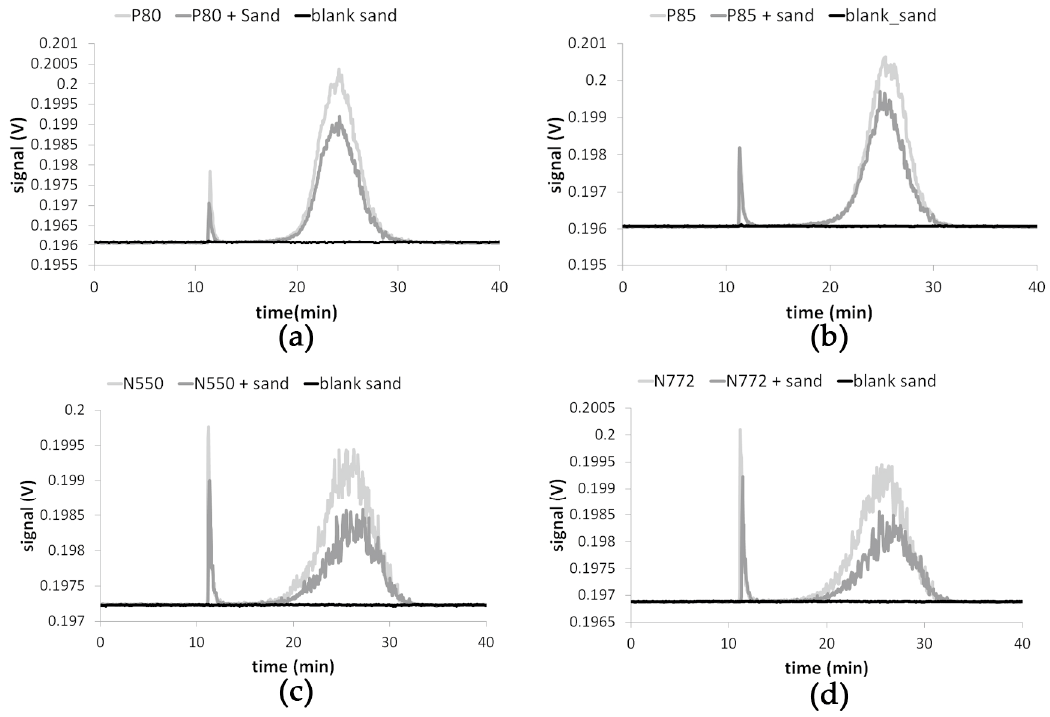
Figure 5. AF4/MALLS fractograms of reference dispersions (dark grey) with no contact to sand and recovery dispersions with contact to sand (bright grey) of 75 ng/mL PX 80 ( a ) and PX 85 ( b ), as well as 125 ng/mL N550 ( c ) and N772 ( d ).